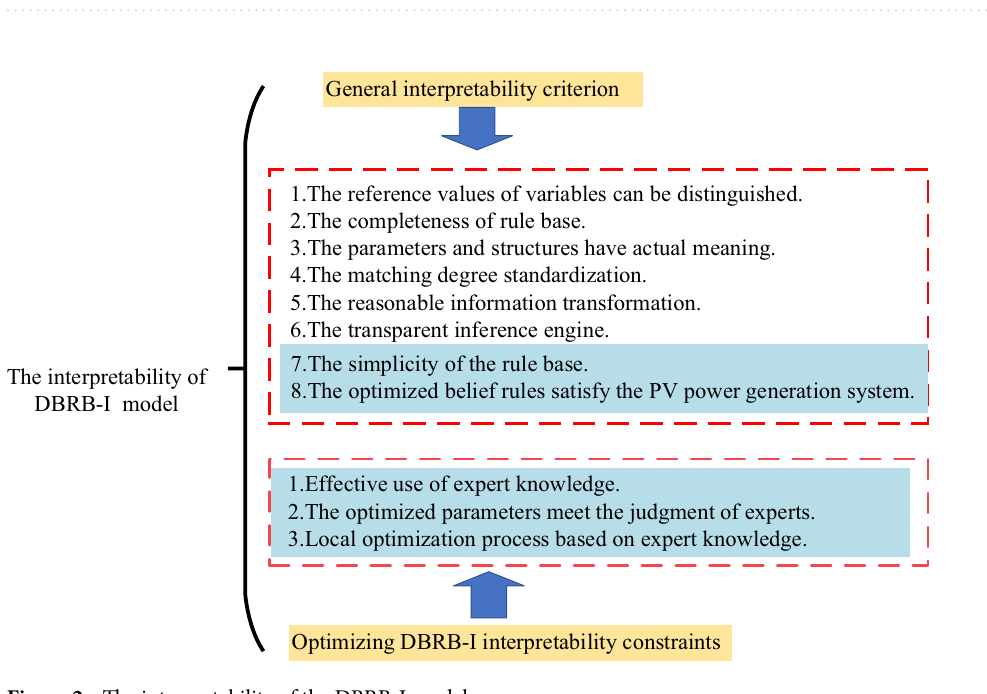
Figure 2. The interpretability of the DBRB-I